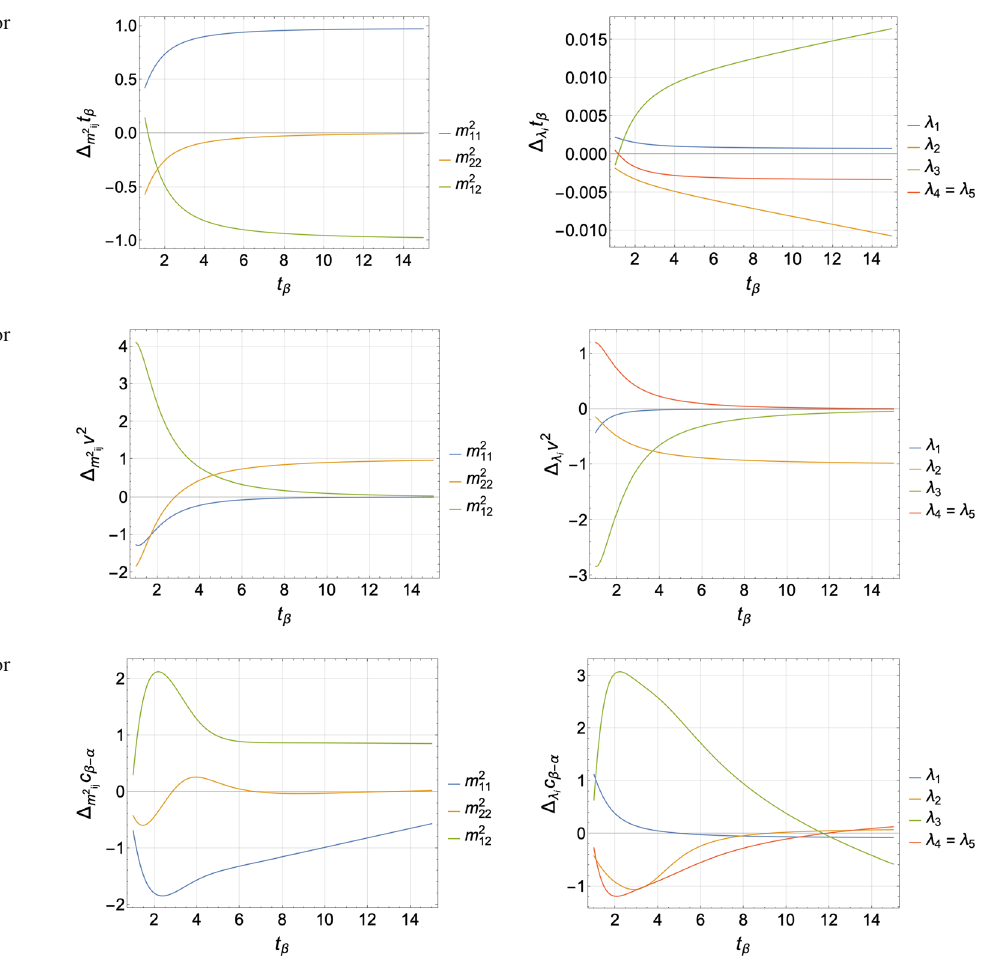
Fig. 12 The same as Fig. 9 for Scenario 4